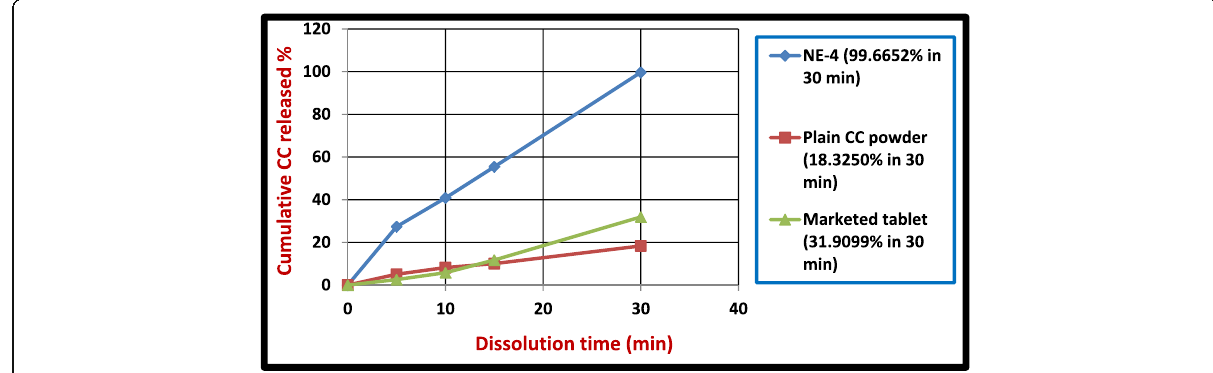
Fig. 9 A comparative dissolution profile of optimum candesartan cilexetil nanoemulsion relative to plain candesartan cilexetil powder and marketed tablet in 900 ml of 0.1 N HCl dissolution medium (pH 1.2) with 0.5% tween 20 at 37